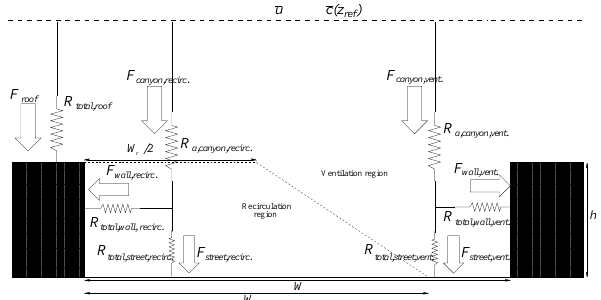
Figure 6. Dry deposition resistance